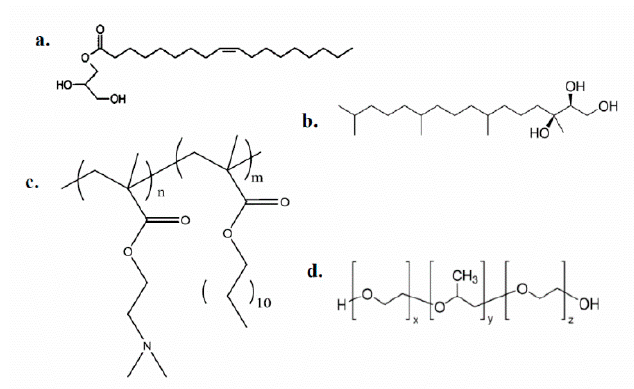
Figure 1. Chemical structures of a. glyceryl monooleate (GMO), b. phytantriol (PHYT), c. poly(2-(dimethylamino)ethyl methacrylate)-b-poly(lauryl methacrylate) (PDMAEMA-b-PLMA), d. Poloxamer P407.